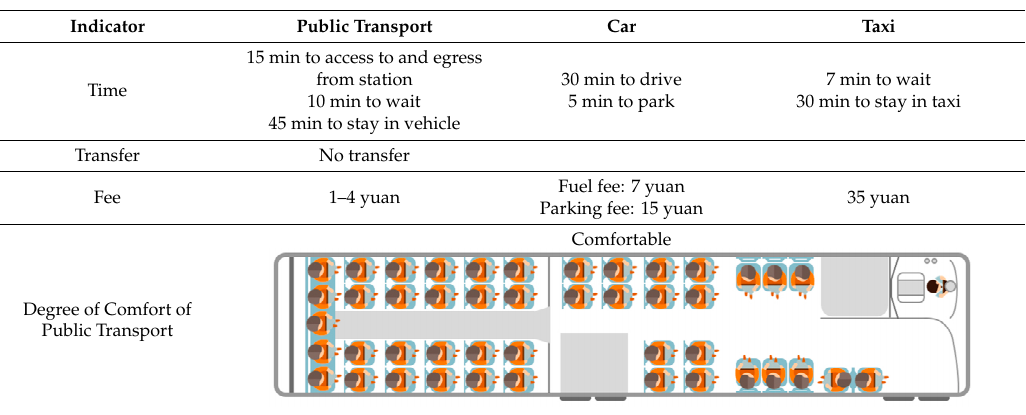
Table 5. Schematic of scenario 6.